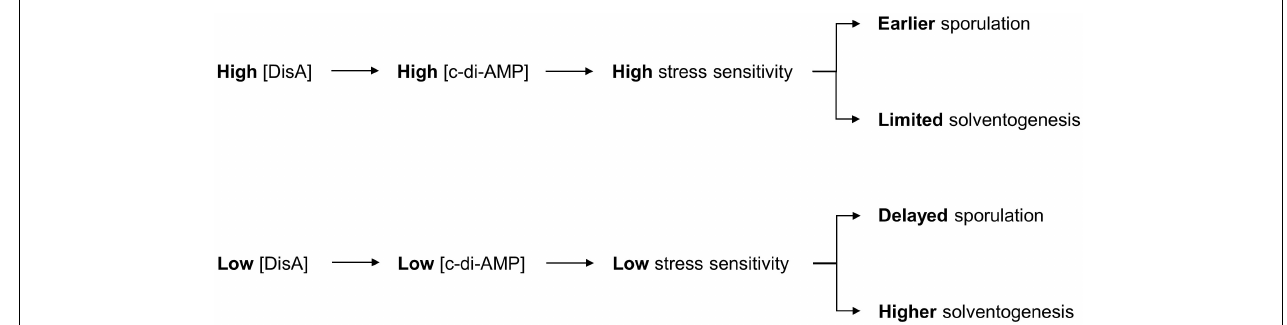
FIGURE 5 | Model for the role of c-di-AMP in ABE production. The depiction includes the normal sequence of events during c-di-AMP production in C. beijerinckii and the role of c-di-AMP in the initiation of sporulation, which impacts the duration of ABE biosynthesis. Decrease in c-di-AMP production following DisA knockdown in C. beijerinckii _M1GS DisA would delay activation of Spo0A, and hence, the onset of sporulation. This delay would therefore extend the solventogenic phase, thereby allowing increased accumulation of ABE